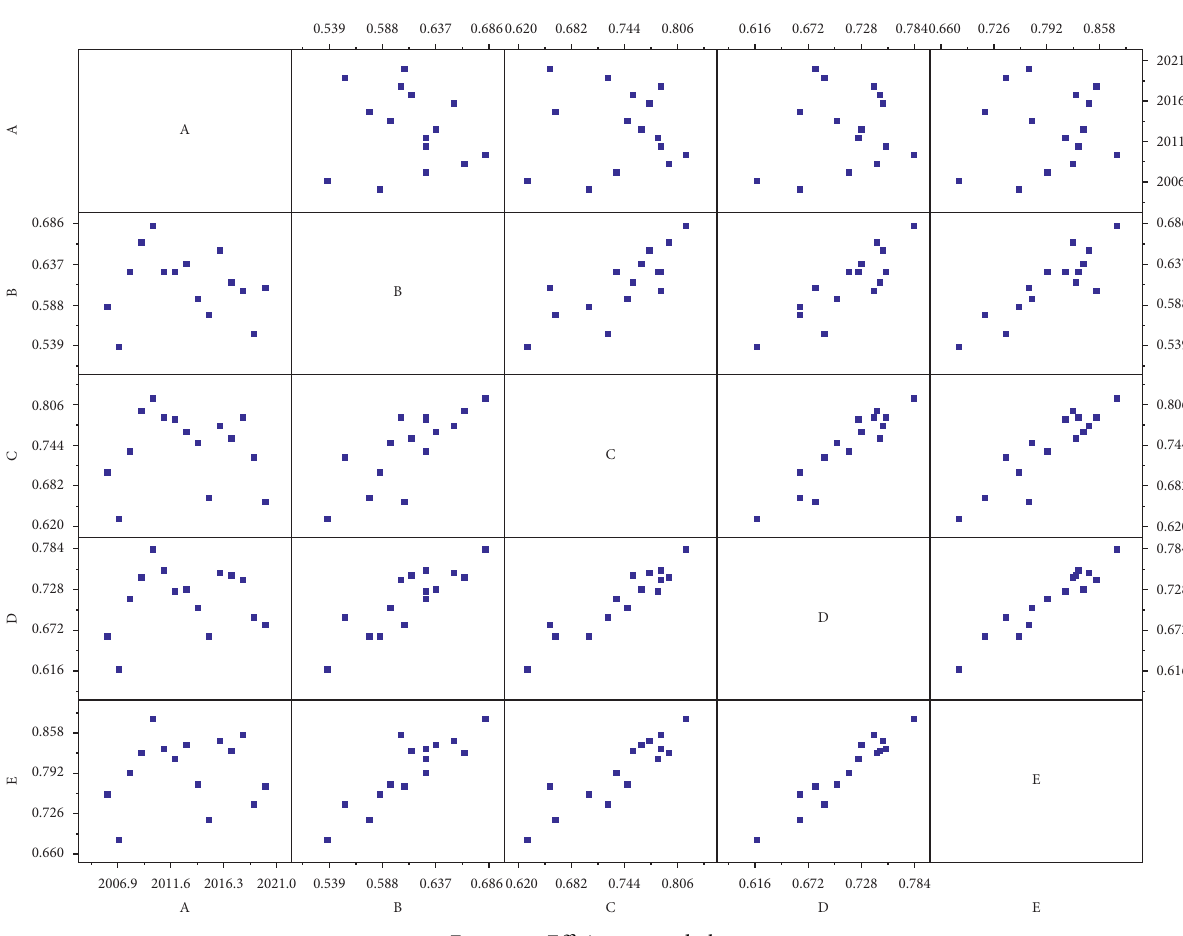
Figure 7: Efficiency trend chart.